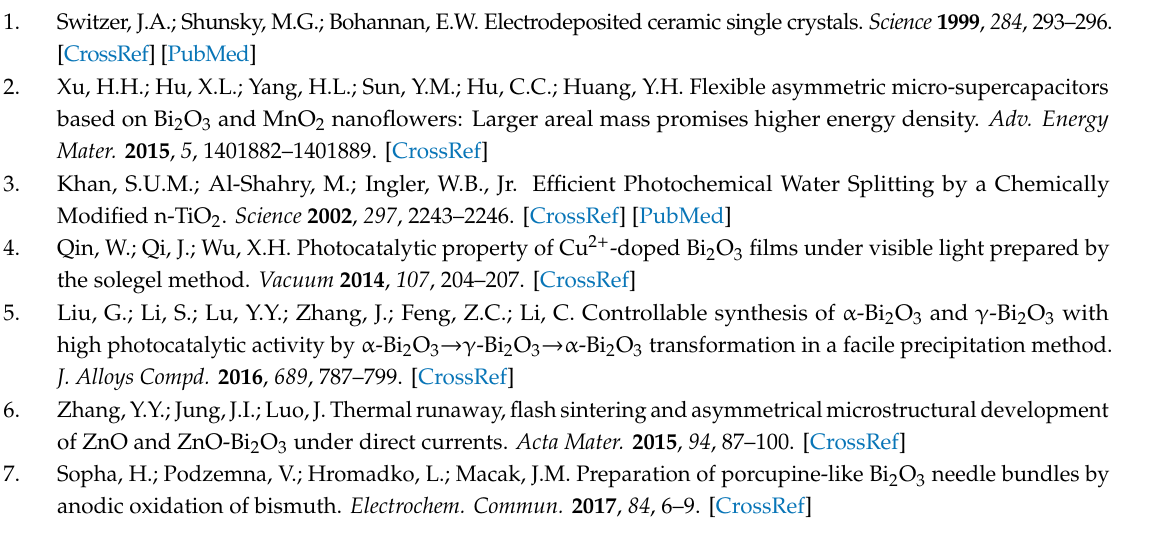
Figure S1: The particle size distribution of nano-Bi2O3; Table S1: Assembly e ffi ciency comparison of di ff erent suspension